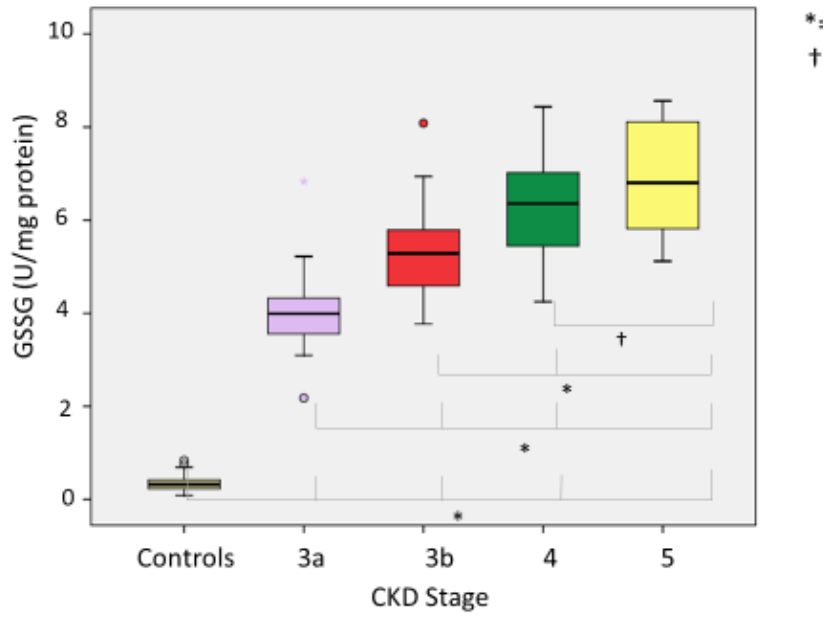
Figure 3. GSSG levels in different stages of CKD.